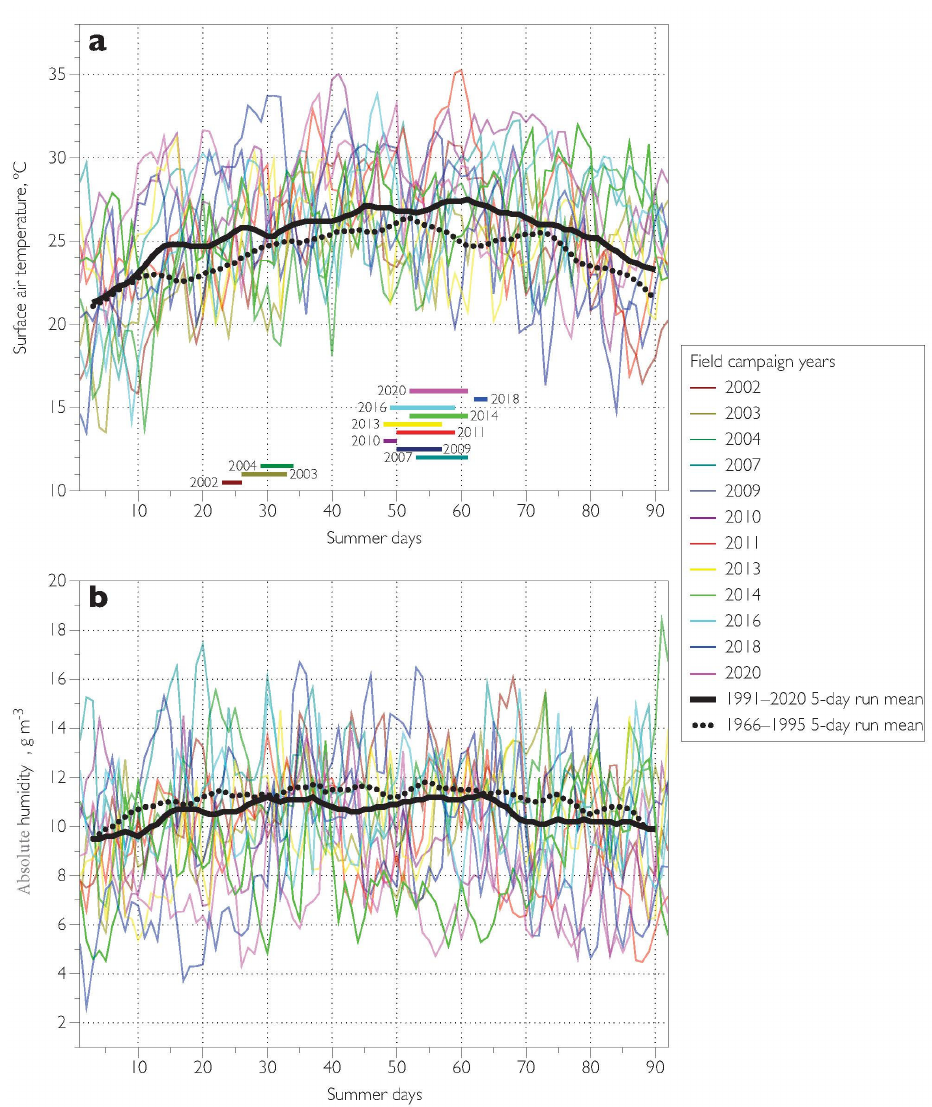
Figure 4. Daily means of summer surface air temperature ( a ) and absolute humidity ( b ) variations in the Yashkul meteorological station (by [64,65]) for each year of field campaign (colored curves). The black bold curves denote 5-day run average of climatic mean values for 1991–2020 (solid lines) and for 1966–1995 (dash lines). Colored horizontal lines at the lower part of the Figure 4a represent the durations of each field campaign.